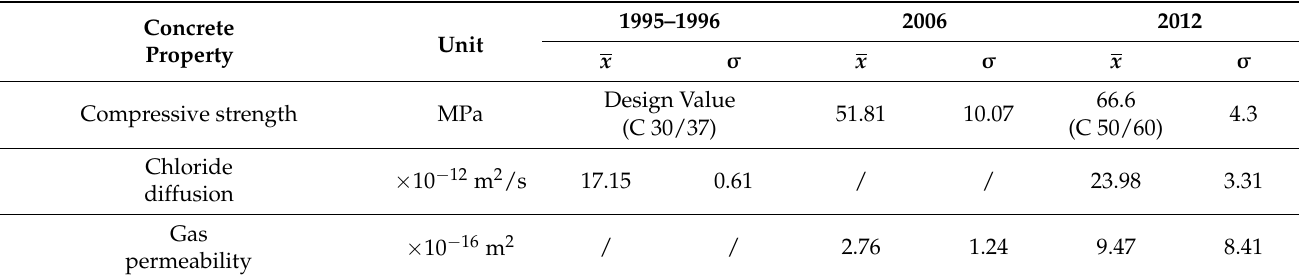
Table 4. Results of some measured parameters carried out on the Maslenica Bridge from construction to